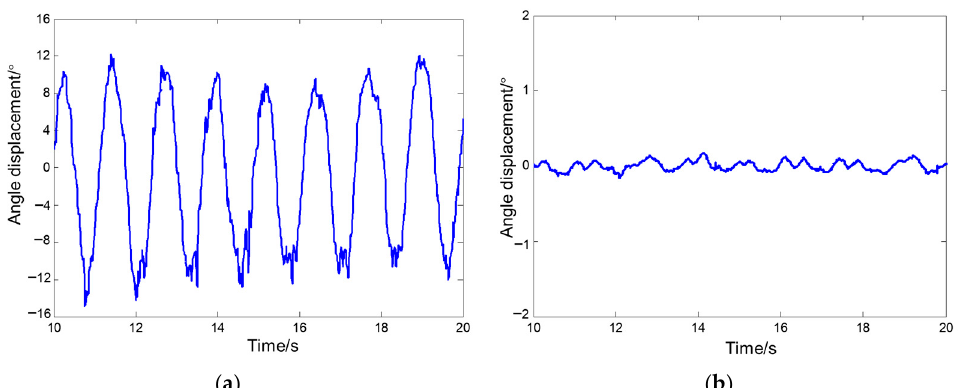
Figure 12. X -axis attitude stability test results of the platform. ( a ) Platform angular displacement ( b ) Angular displacement of load equipment after leveling.